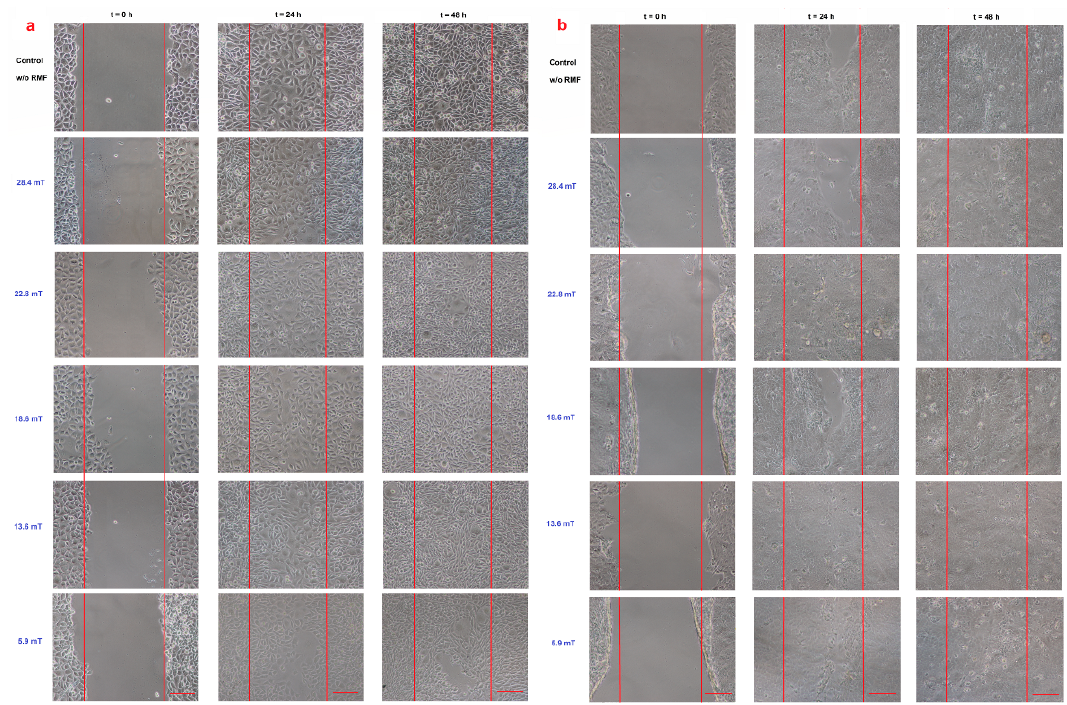
Figure 5. Wound healing assay ( a ) L929 cell line and ( b ) HaCaT cell line in different magnetic induction values; scale bar = 50 μ m.